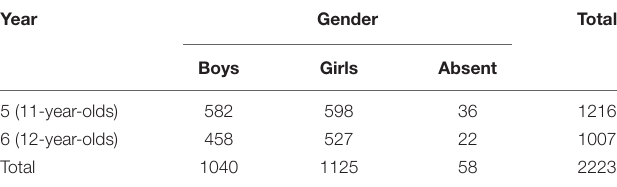
TABLE 1 | Characteristics of the